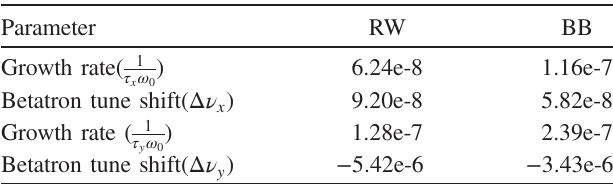
TABLE III. Growth rate and tune shift of the 0 mode instability.